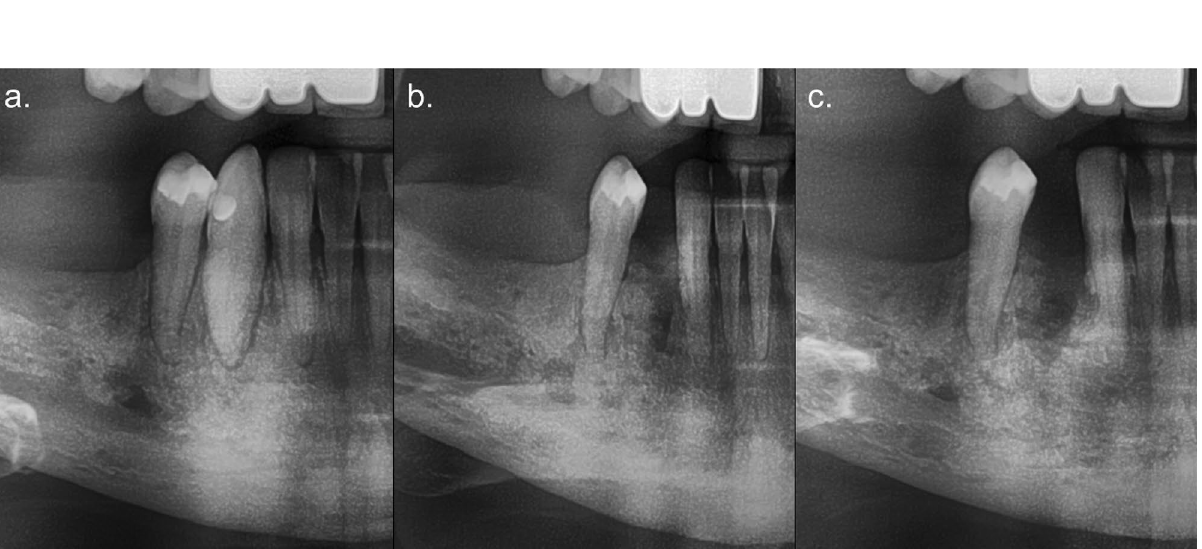
Figure 2. Cropped panoramic radiographs of a 67-year-old female in treatment with denosumab, showing tooth 43 two months before extraction ( a ), and ten ( b ) and eighteen months after ( c ). This site had absence of periapical lesion and angular bone defect, but presence of sclerosis and widening of the periodontal ligament space. Osteonecrosis was diagnosed eight weeks after surgery, as the site did not heal. Persistence of the alveolar socket and sclerotic pattern can be seen